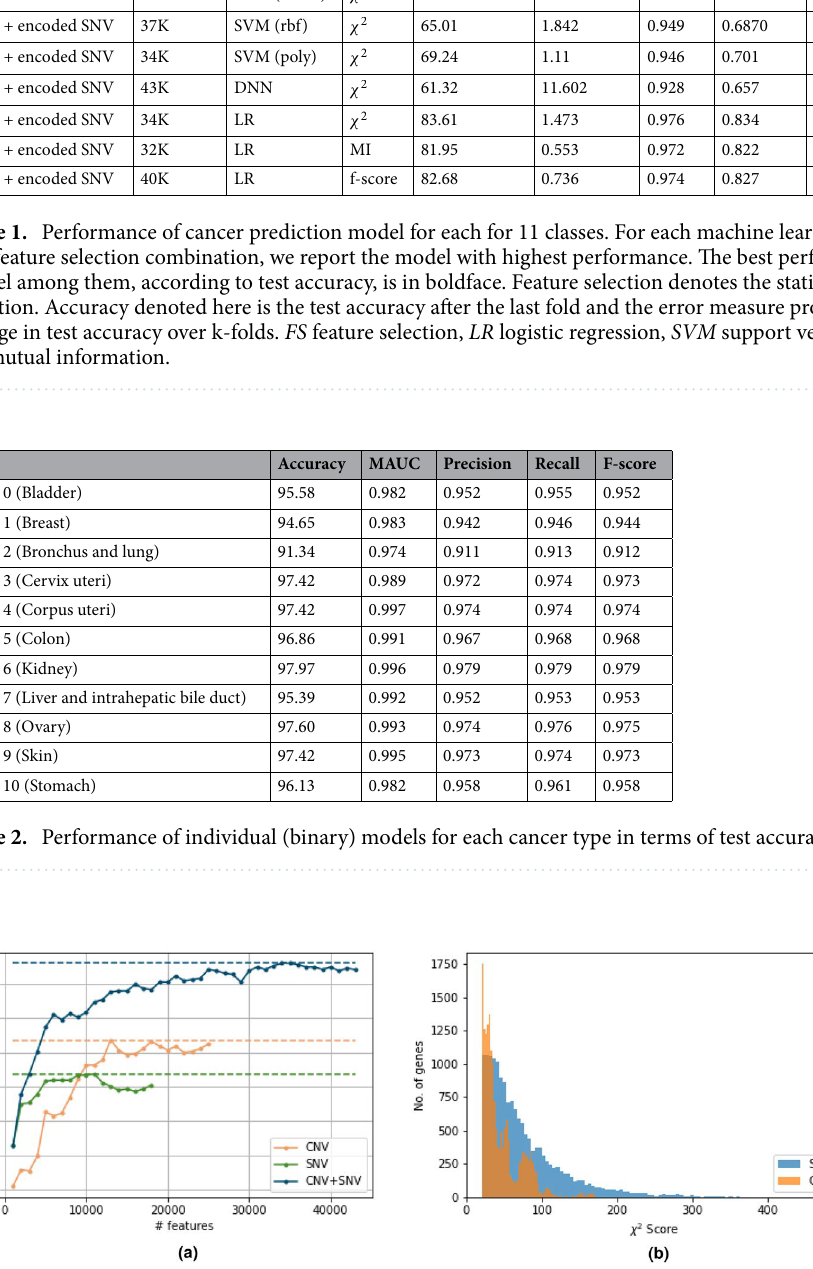
Figure 4. ( a ) Variation of the achieved test accuracy of the trained models with different number of features 2 selected using χ test. ( b ) The distribution of feature scores for genes contributing CNV and SNV data in the final